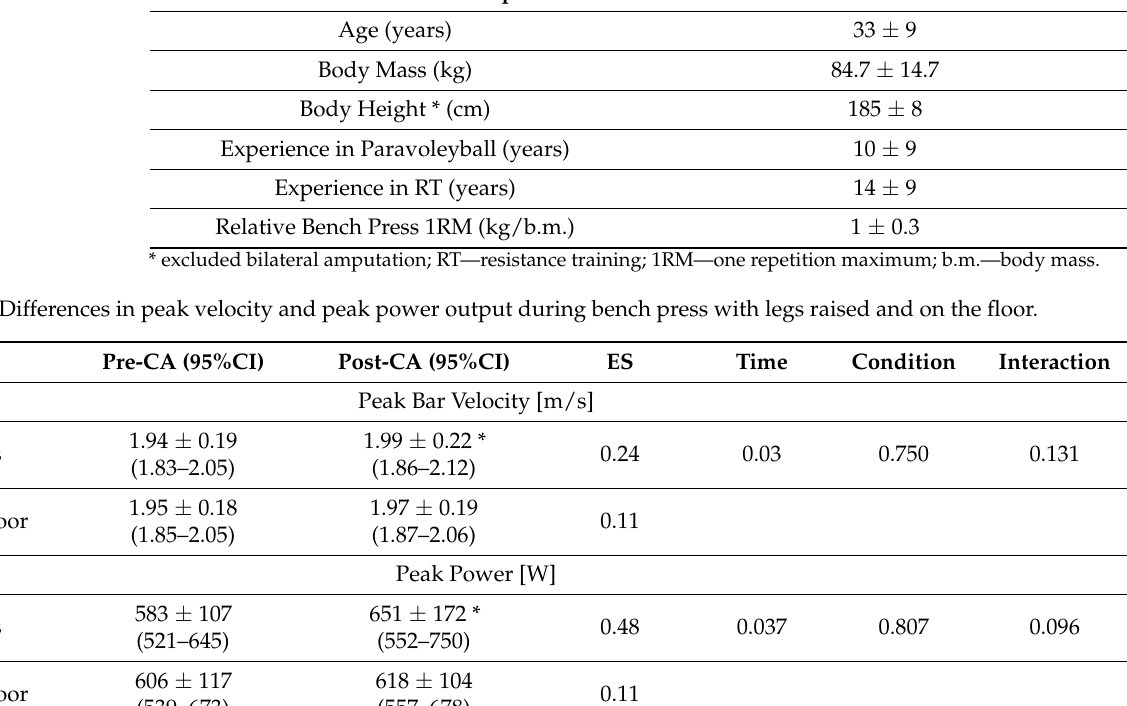
Table 1. Descriptive characteristics of study participants. Characteristic of Group